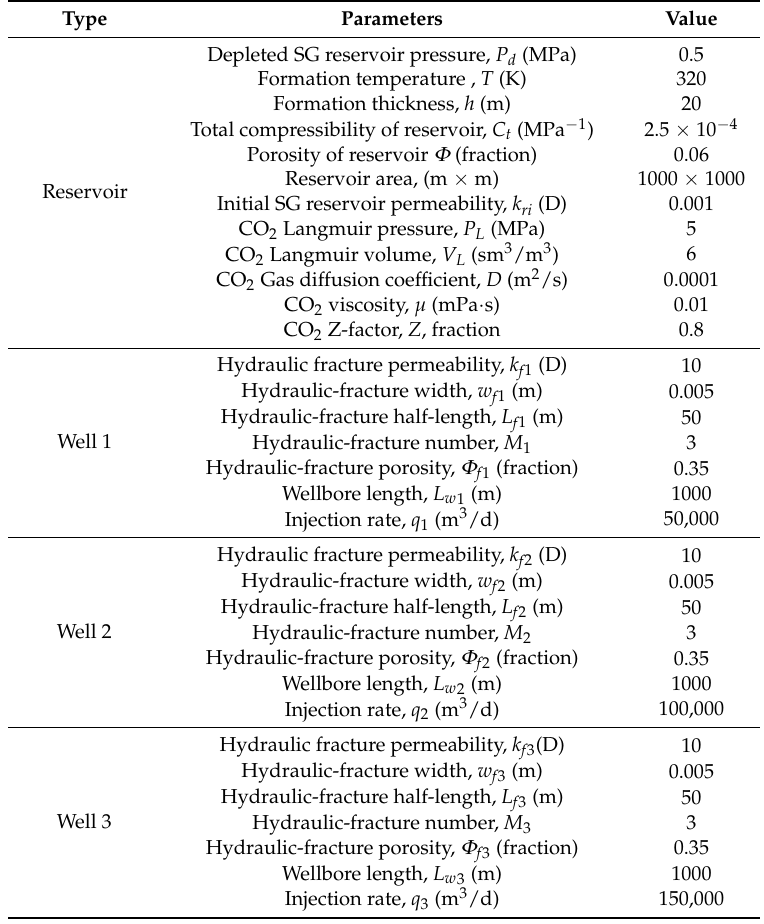
Table 1. The basic parameters for numerical